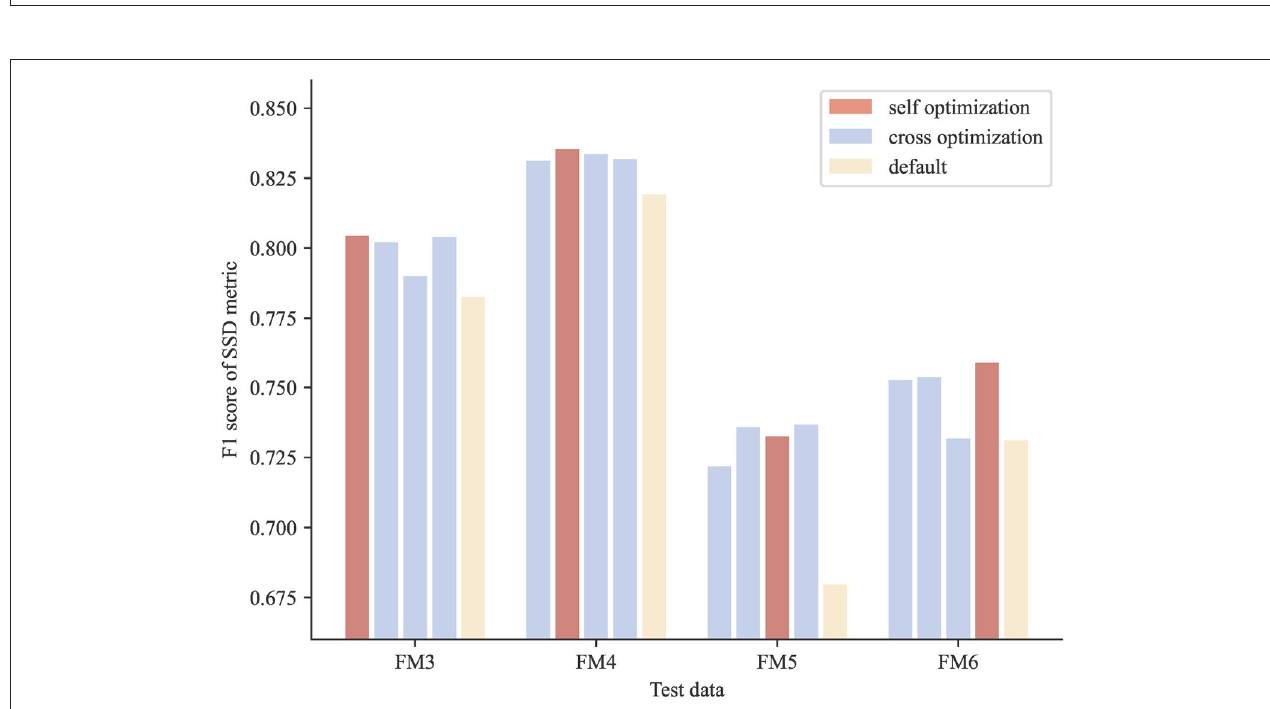
FIGURE 6 | Cross-validation results of parameter optimization for neuron reconstruction. The scores of the optimized parameters are consistently better than those of the default parameters for all the test images.